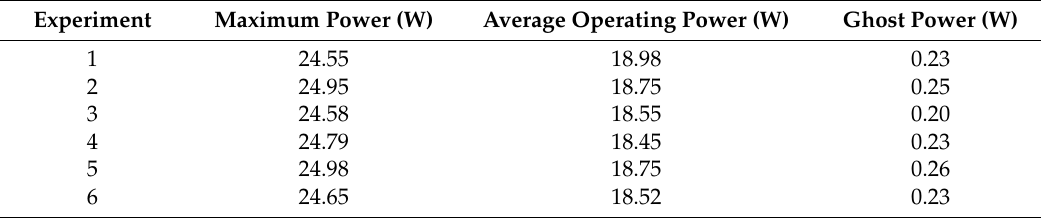
Table 5. Total power of experiment results.